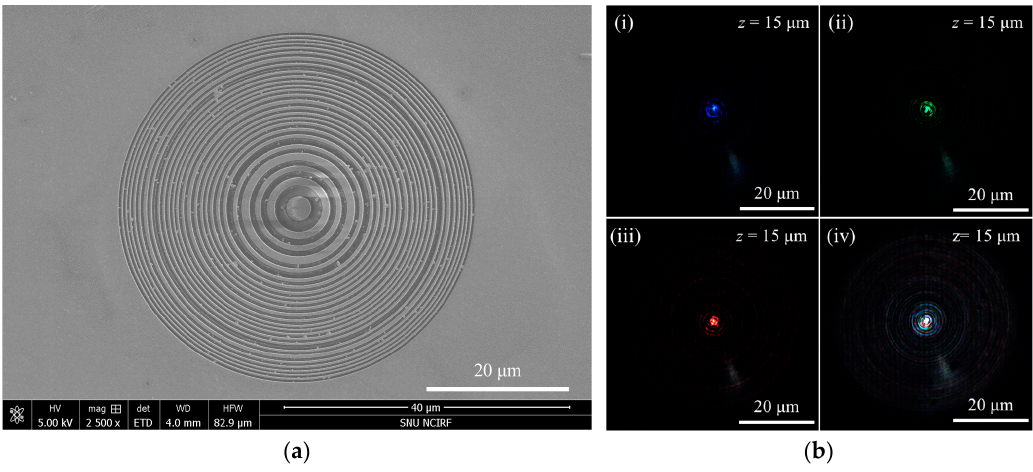
Figure 7. Experimental characterization of the fabricated multi-chromatic mono-focal MFZP: ( a ) SEM image of the fabricated MFZP. ( b ) Images of the transmitted light through the MFZP at z = 15 µ m with respect to incidence wavelength: (i) λ = 473 nm (blue), (ii) λ = 532 nm (green), (iii) λ = 660 nm (red), and (iv) combined RGB incidence (white).